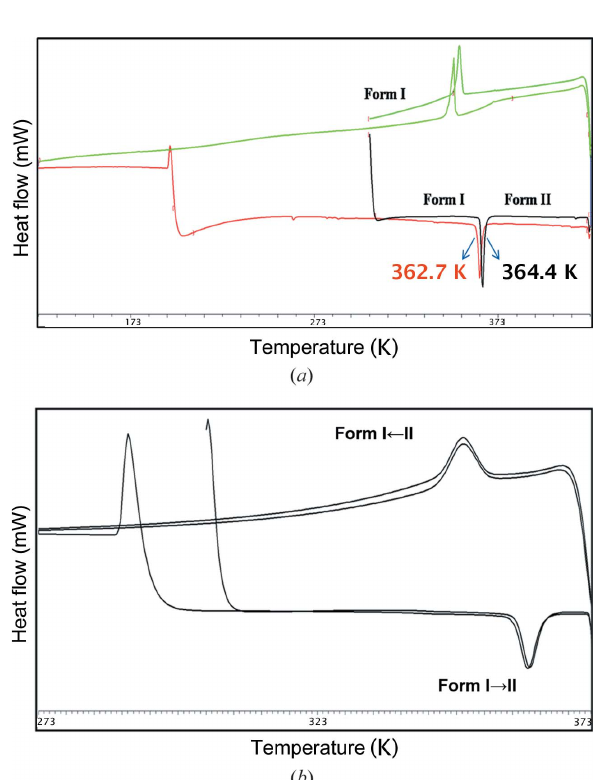
Figure 10 ( a ) DSC thermogram of Compound-C Form I (heat–cool–reheat). ( b ) DSC thermogram of Compound-C Form I ground material (heat–cool– reheat).